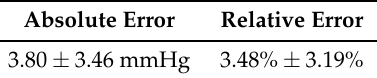
Table 4. Blood pressure estimation (BPE) approach according to Kuryalak et al. [31]: performance measures applied in the original publication. Absolute error: absolute magnitude between estimated systolic blood pressure (SBP) and reference SBP; relative error: absolute error divided by corresponding reference SBP.